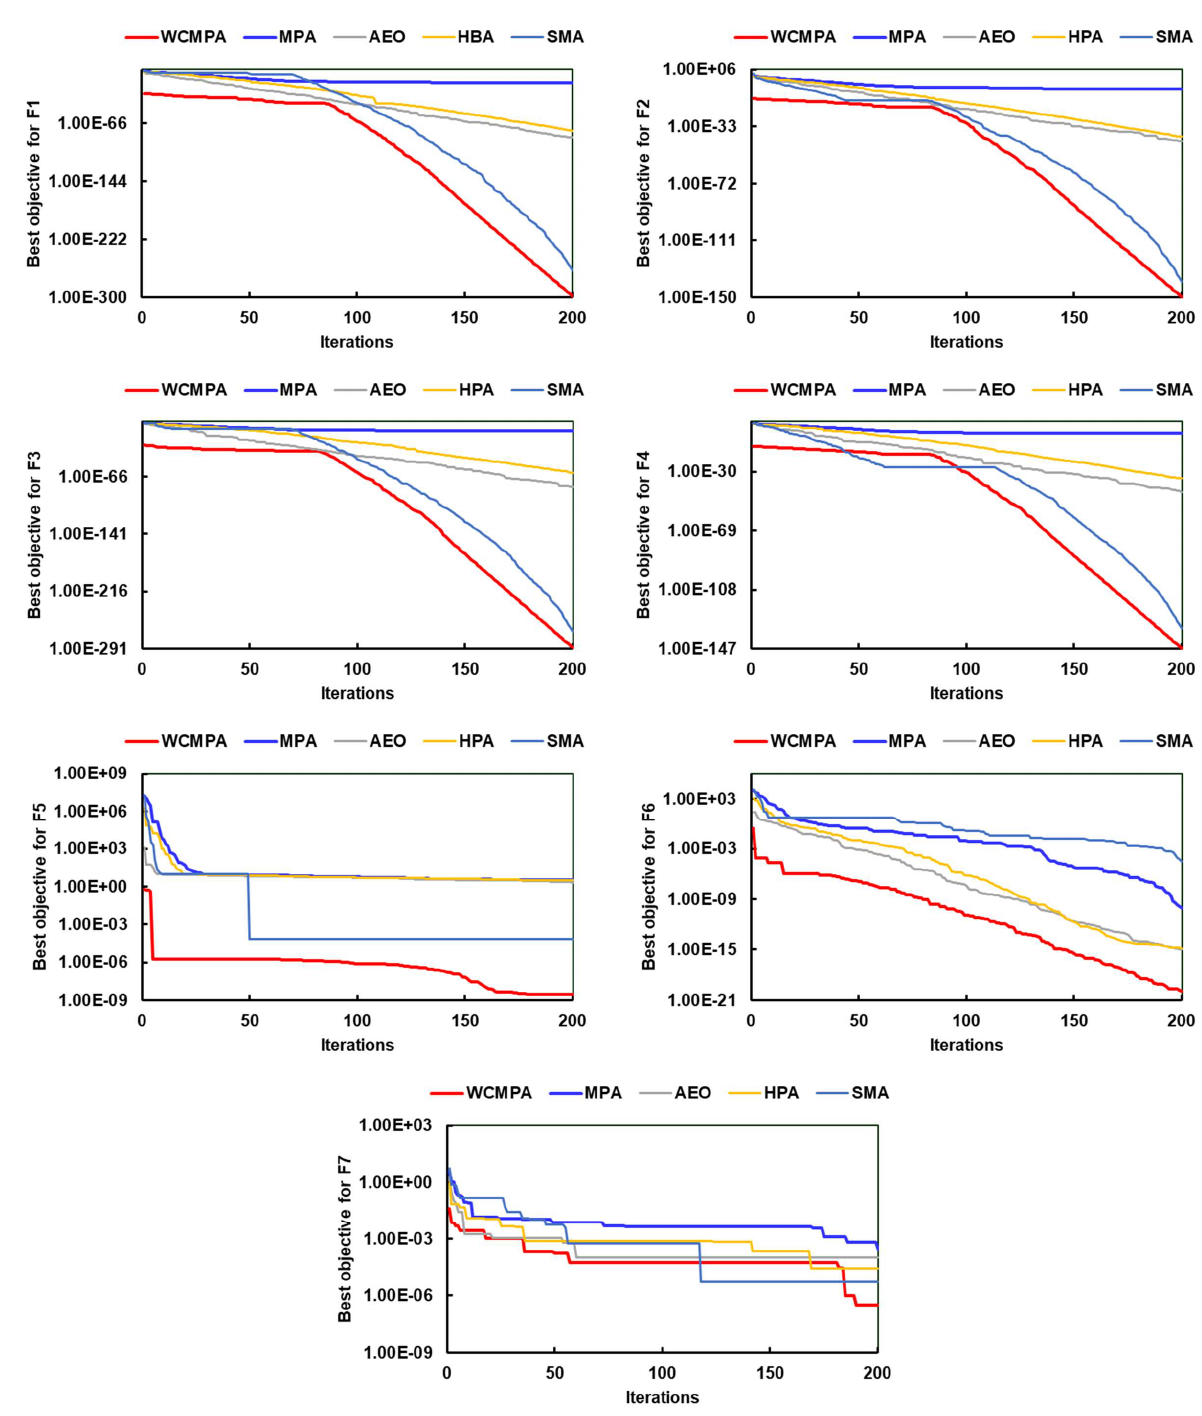
Figure 9. Unimodal benchmark functions. (E is the Scientific